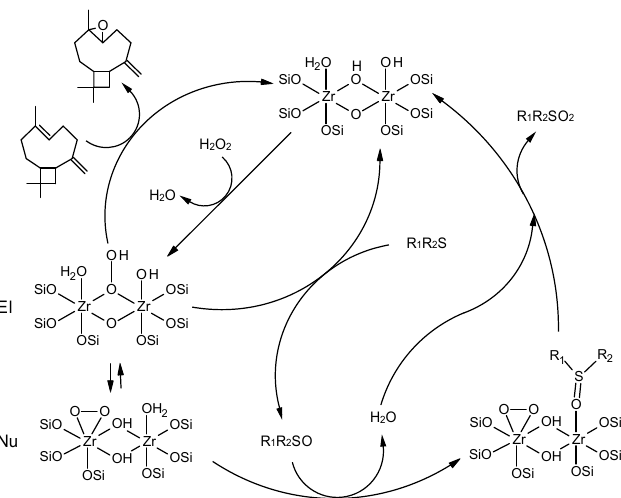
Scheme 4. Tentative mechanism of CP and MPS oxidation with H 2 O 2 over Zr-silicate.